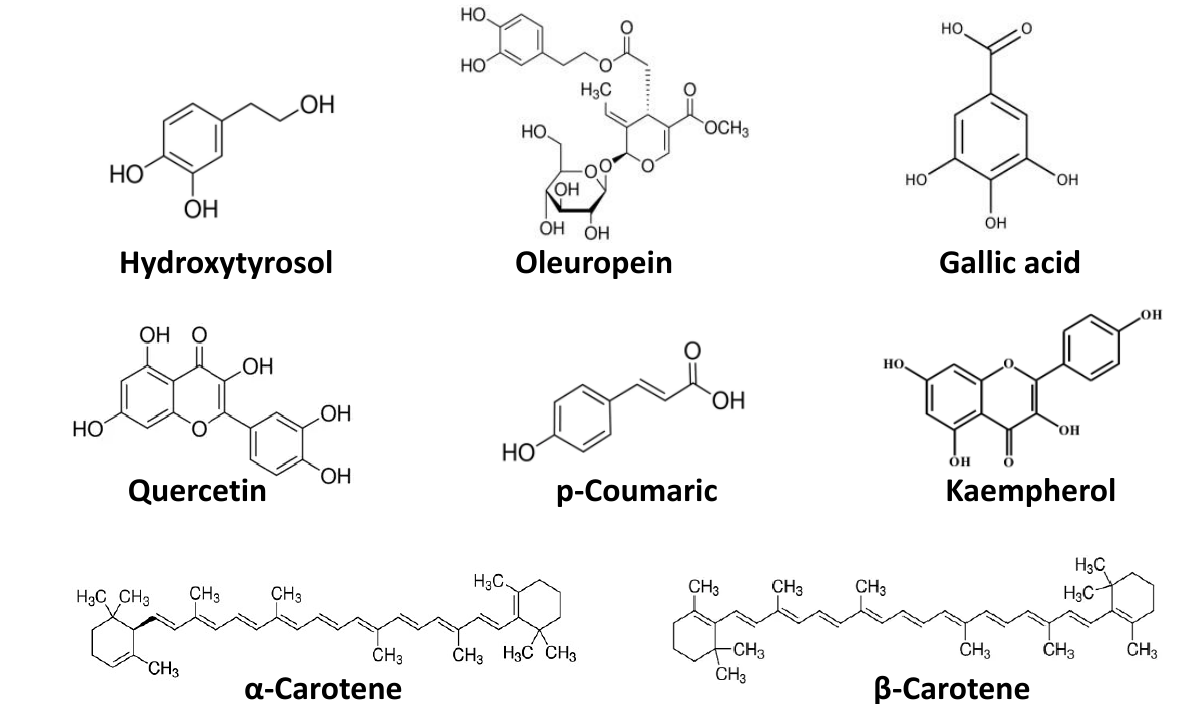
Figure 2. Chemical structures of common dietary phytochemicals.